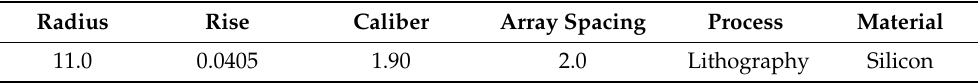
Table 1. Complex eye lenslet array process design parameters (unit: